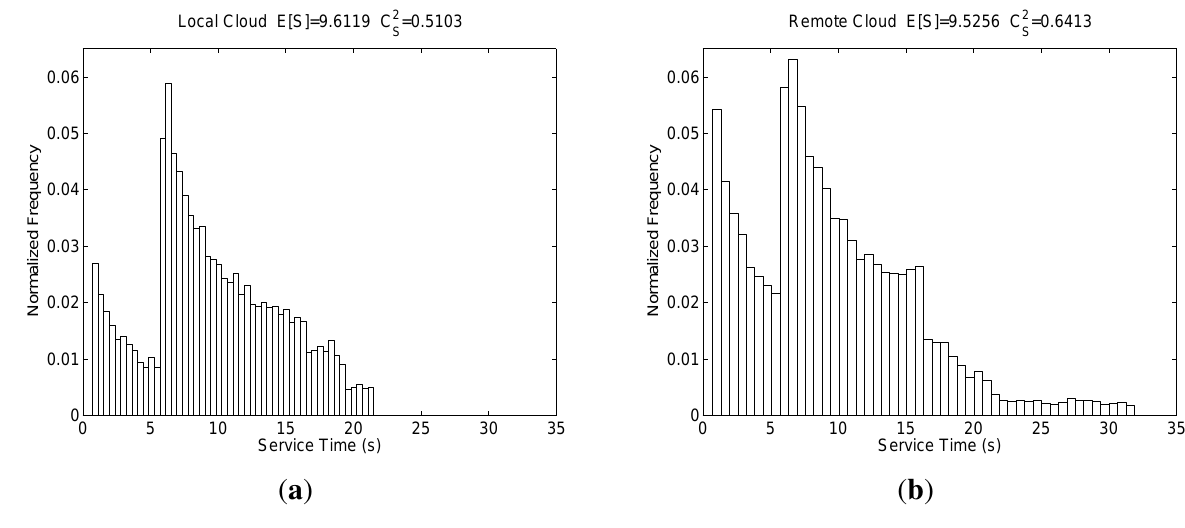
Figure 2. Normalized histograms of service times. ( a ) Local cluster; ( b ) Remote cluster.